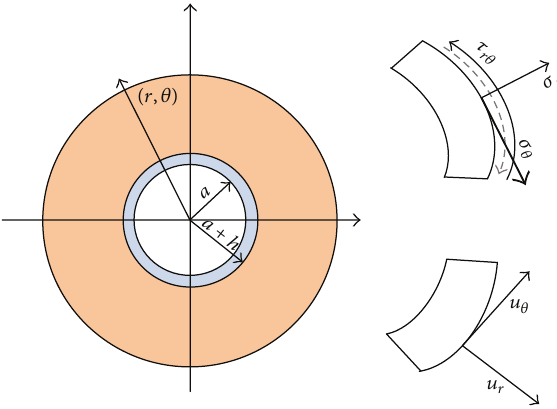
Figure 4: A soil elastic continuum